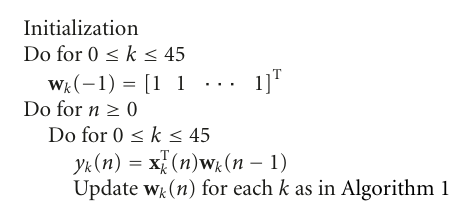
Algorithm 2: Complete Hybrid algorithm.